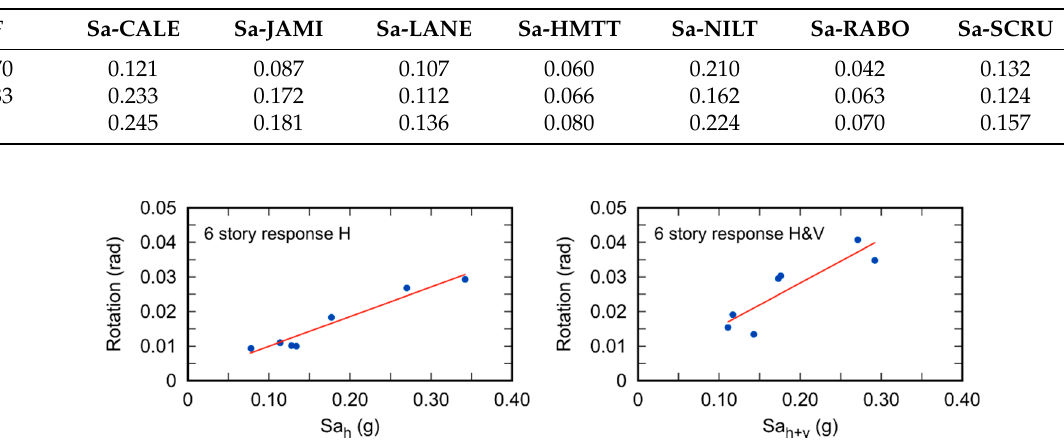
Table 8. Accelerations due to vertical earthquake in the 10-story building. Table 9. Resultant accelerations of the horizontal plus vertical components (10-story building).